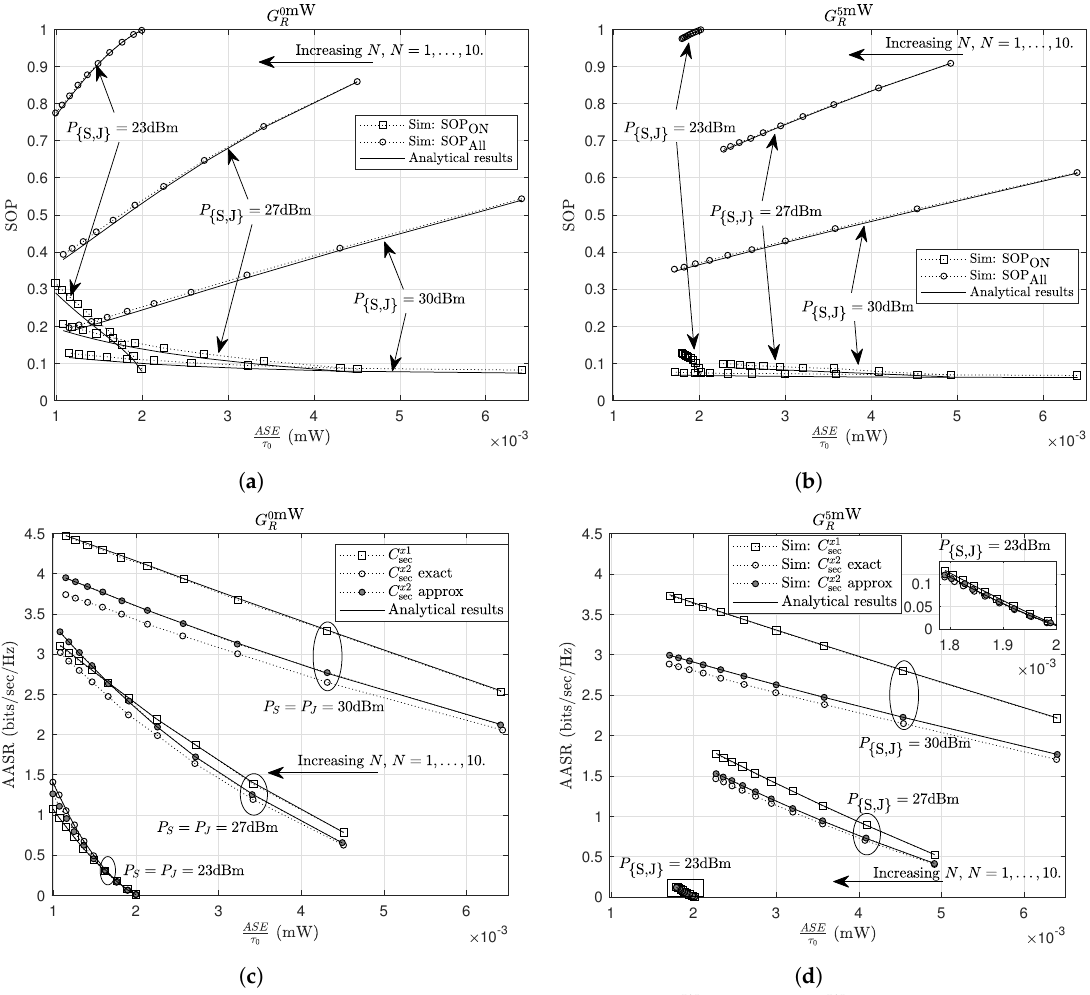
Figure 7. The trade-off between the SOP and the ASE for ( a ) G 0mW between the AASR and the ASE for ( c ) G 0mW